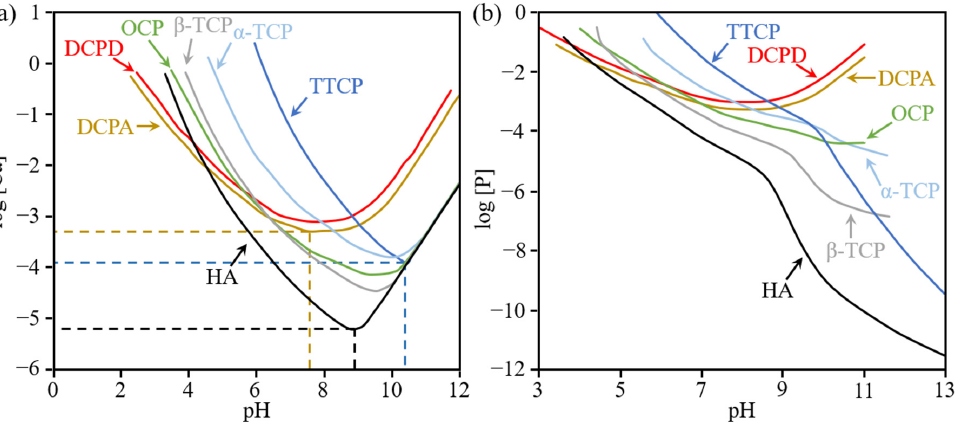
Figure 6. A representation of the calcium phosphate precipitation. Calcium phosphate compounds can be divided into 11 different types, depending on the Ca/P ratio (Table 2). The formation of each of them highly depend on the pH of the solution and time (Figures 7 and 8).